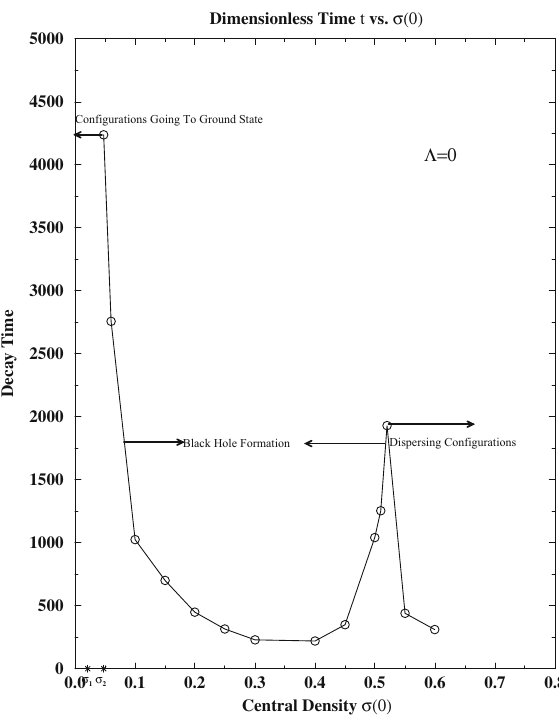
Fig. 13 The instability time scale of an excited boson star (the first excitation) to one of three end states: (i) decay to the ground state, (ii) collapse to a black hole, or (iii) dispersal. Reprinted with permission from Balakrishna et al. (1998); copyright by